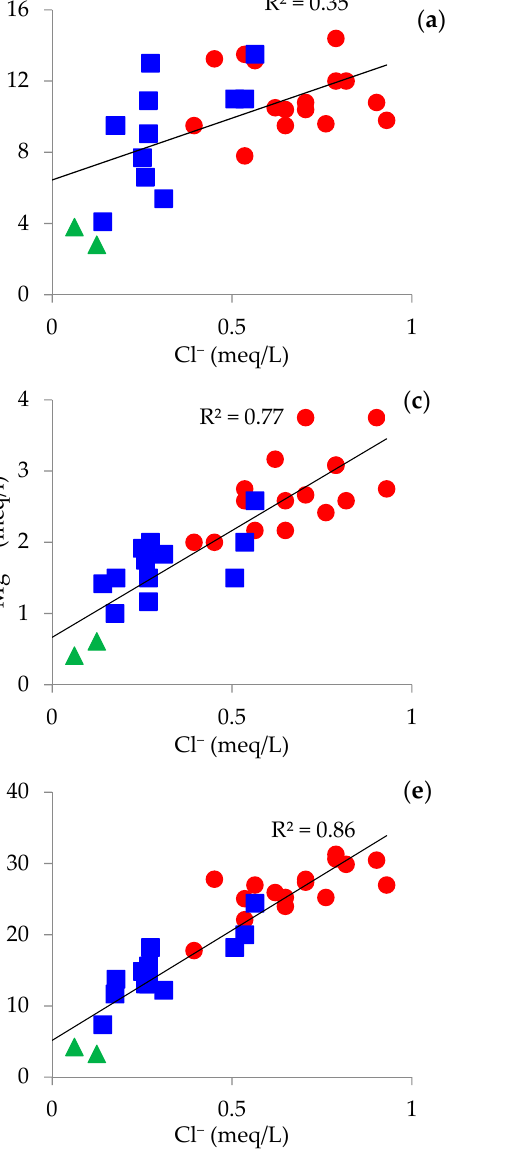
Figure 4. ( a ) Ca 2+ , ( b ) Na + , ( c ) Mg 2+ , ( d ) K + , ( e ) HCO 3 − , and ( f ) SO 42 − (in meq/L) vs. Cl (in meq/L) binary diagrams for the Choygan spring waters. The symbols are the same as for Figure 3.